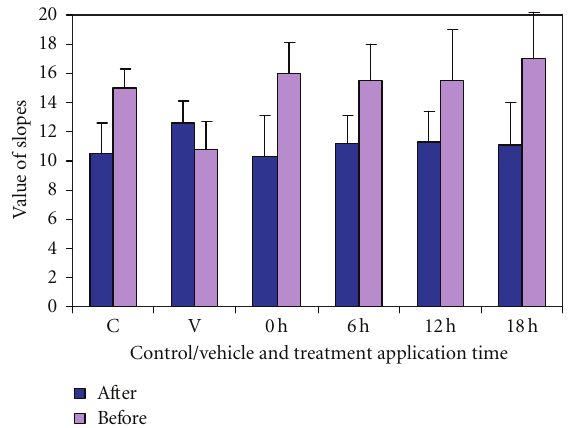
Figure 9: Values slope the day before and 7 days after models of focal ischemia. P values in paired rank test of Wilcoxon. ( n = 35 per group) Dose Neuro-EPO IN 249.4 UI.